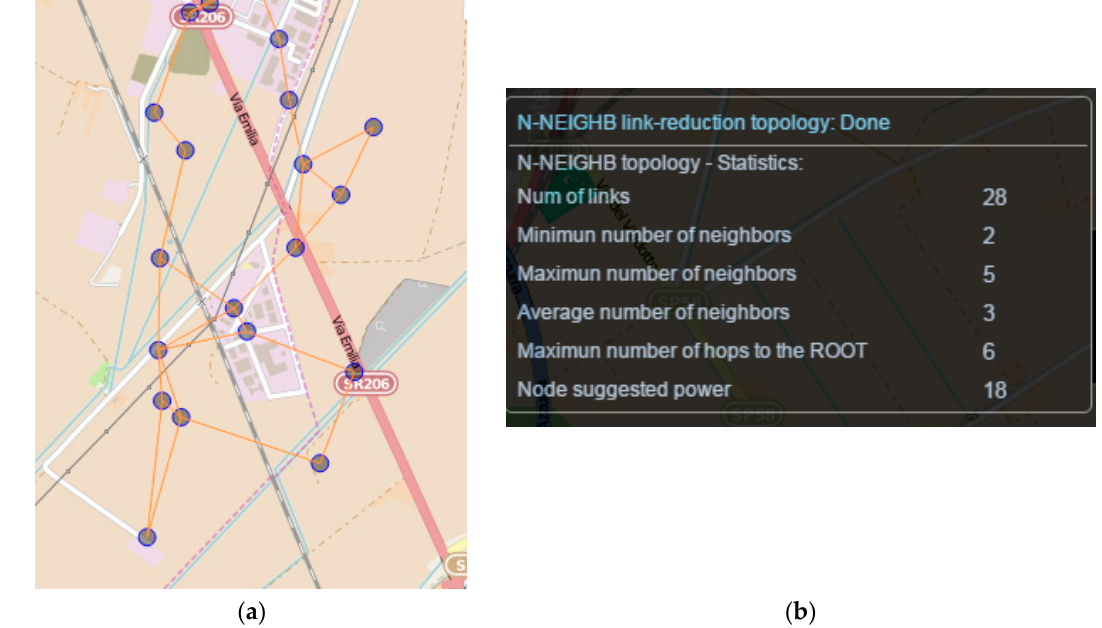
Figure 9. WSN-DPCM N-Neighbor Link Reduction Integrated Algorithm (power in dBm): graphical results ( a ) and statistics ( b ).